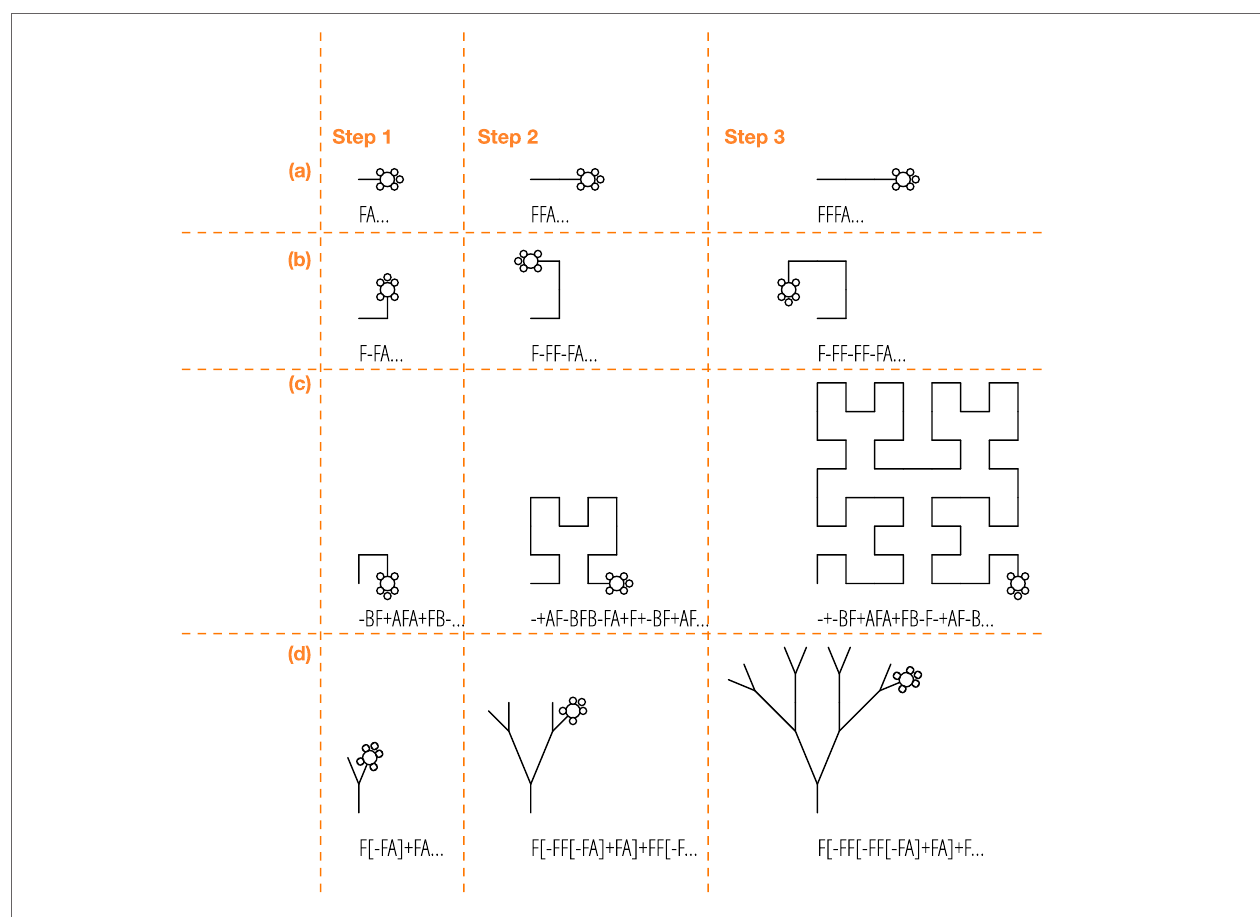
FigUre 1 | The first three production steps of four different L-systems (a–D) are illustrated by means of the turtle